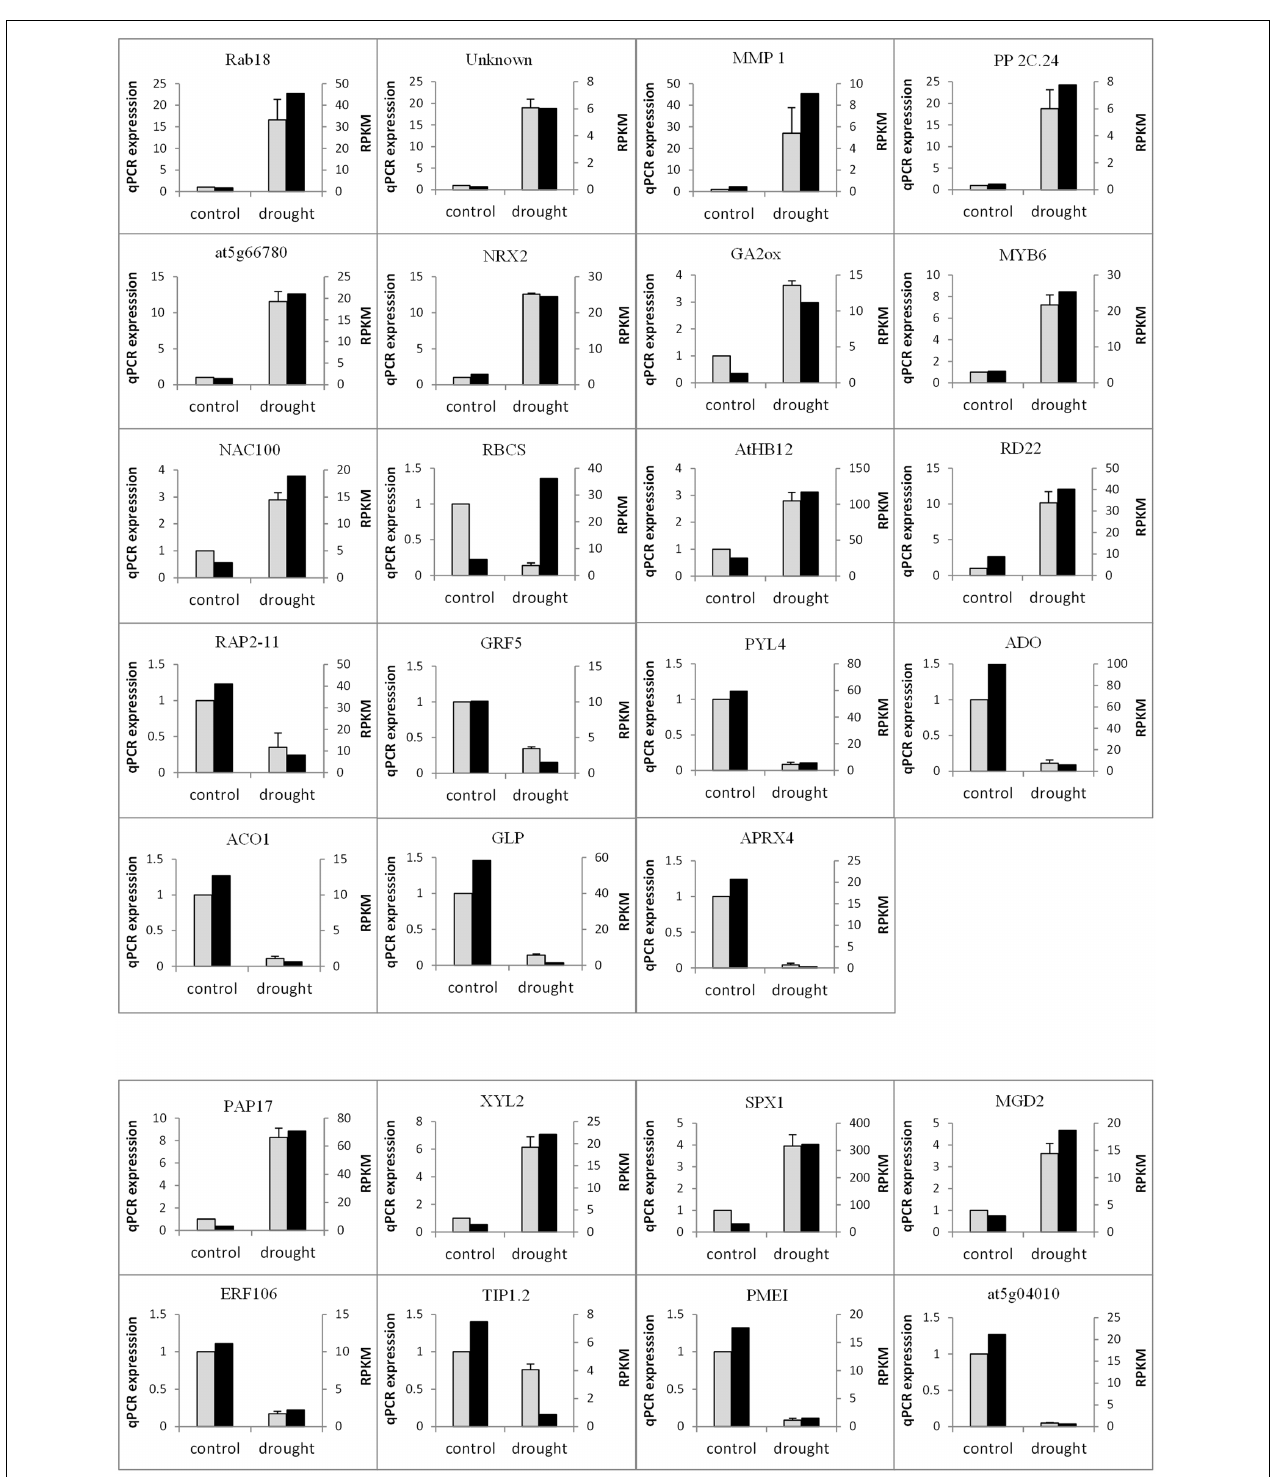
FIGURE 6 | Quantitative reverse transcription polymerase chain reaction (RT-qPCR) validation of selected genes in roots (GF677 rootstock) and leaves (graft, var. Catherina) in the control and drought-stressed plants. The gray bars represent the relative expression determined by RT-qPCR (left y -axis) and the black bars represent the level of expression (RPKM) of the transcripts (right y -axis). The relative expression in the RT-qPCR analysis was normalized to the level in the GF677 rootstock of the control plants. The error bars indicate the standard error of quad-biological and bi-technical replicates. See abbreviations and further information about each gene in Supplementary Table